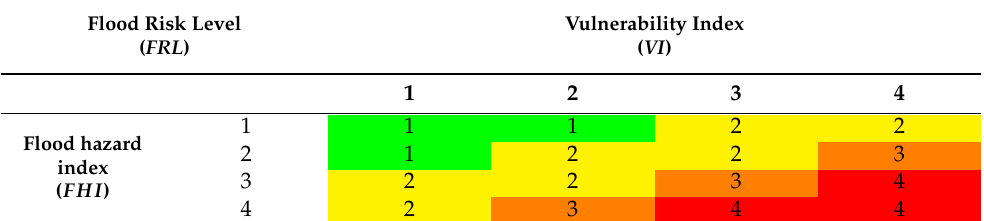
Table 5. Values of flood risk level FRL .